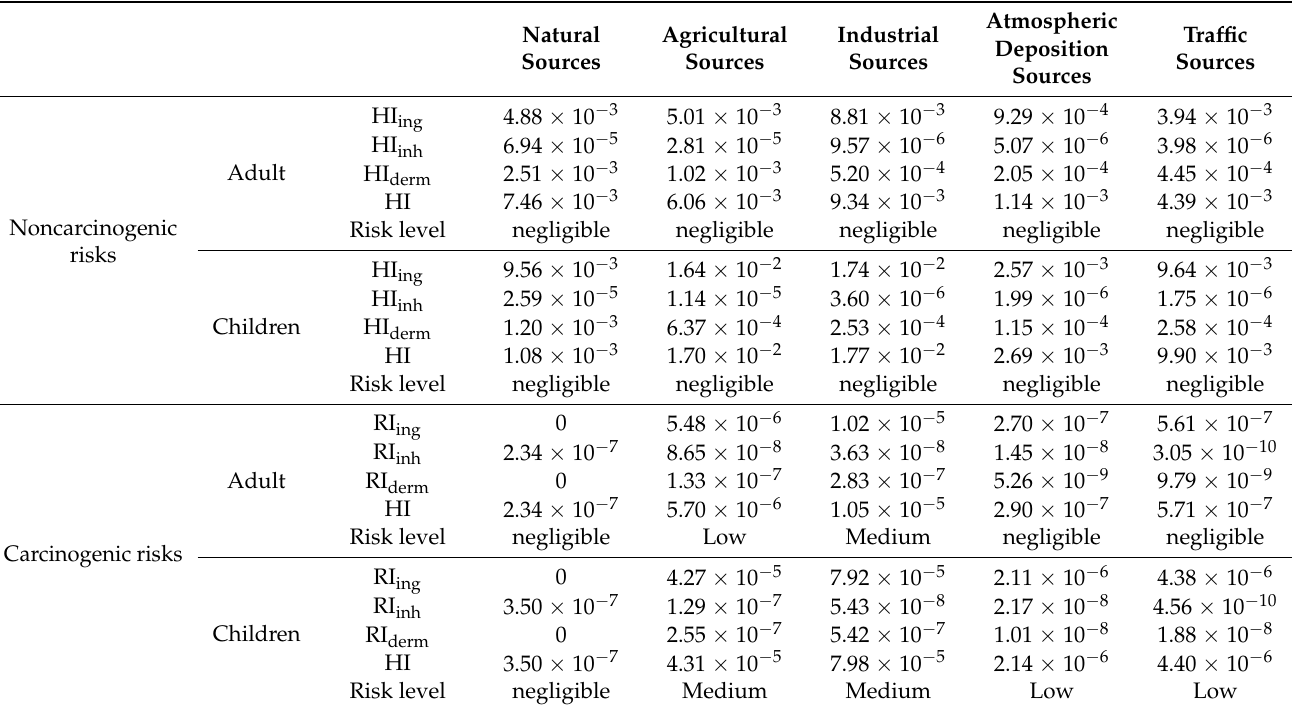
Table 5. Health risks to adults and children from different channels based on different